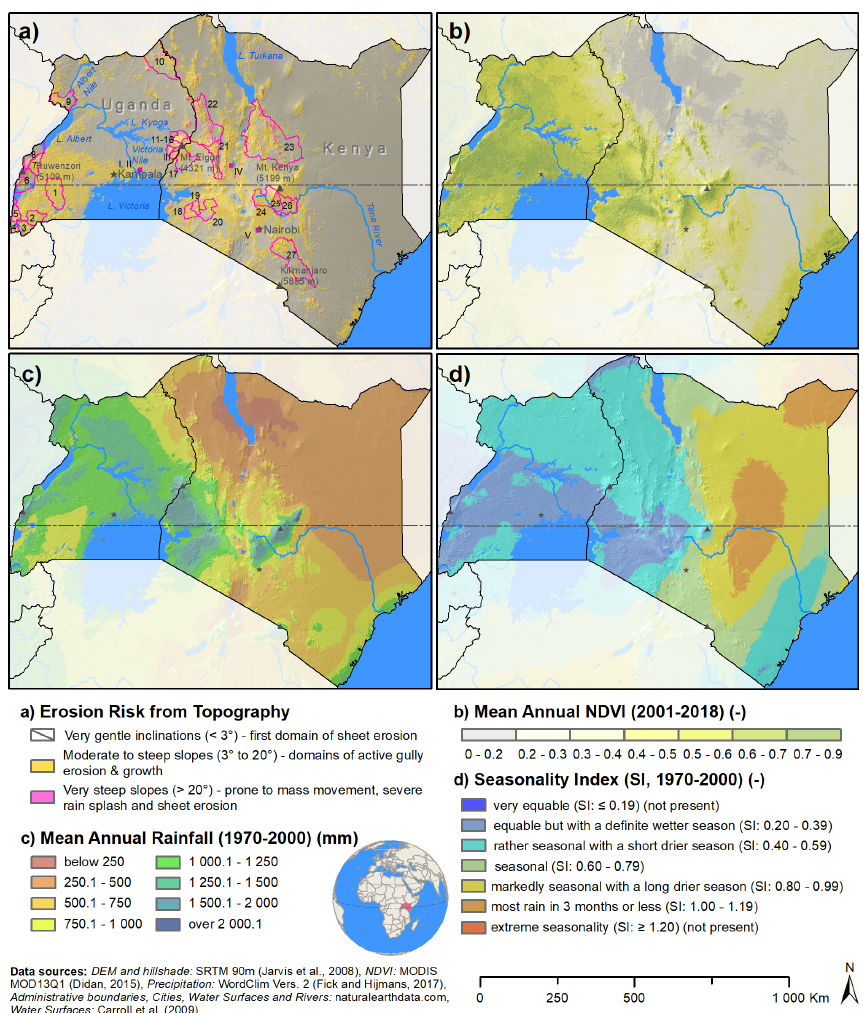
Figure 1. Study area of Kenya and Uganda. A classification of the soil erosion risk following Ebisemiju (1988) (a) , the mean annual MODIS NDVI as a proxy for vegetation cover (b) , mean annual rainfall (c) , and the rainfall seasonality index (SI, Walsh and Lawler, 1981) (d) are plotted to characterize spatial properties of the study region. The boundaries for administrative units where the mean soil loss was assessed are shown with pink outlines in panel (a) . Locations of soil loss assessments from previous studies that were used for comparison are shown as pink squares. The hillshade is plotted in grey in the background to characterize the terrain